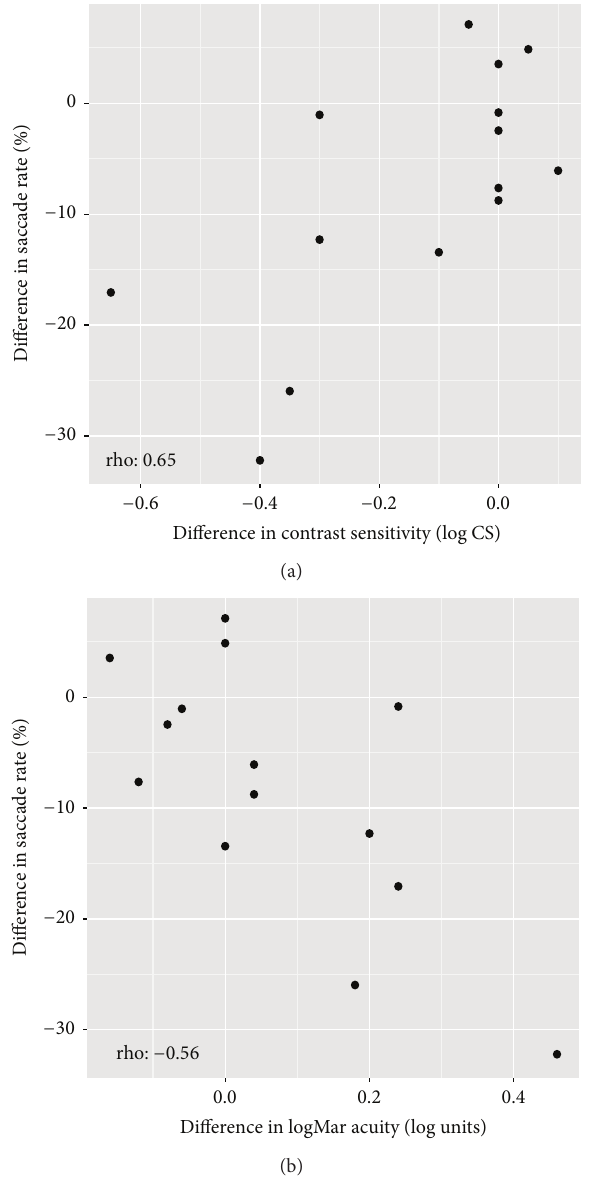
Figure 4: Scatterplots depicting the statistically significant rela- tionships between (a) the difference in contrast sensitivity (log) and percentage difference in saccade rate between eyes and (b) the difference in logMAR visual acuity and the percentage difference in saccade rate between eyes.